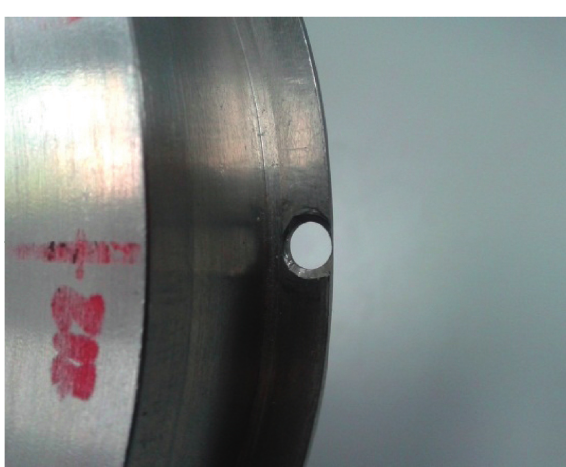
Figure 22: Zoomed image of the flange of the cover.